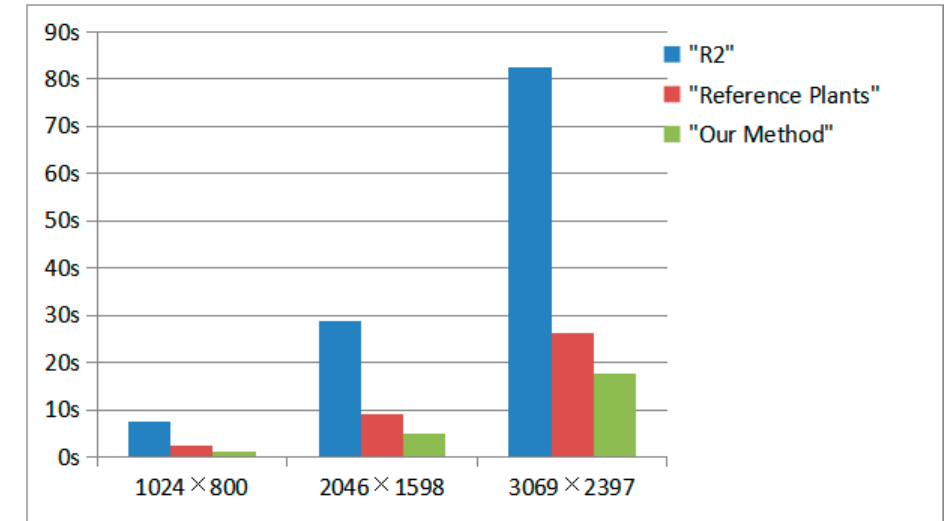
Figure 18. Comparison of computational time required by various algorithms.